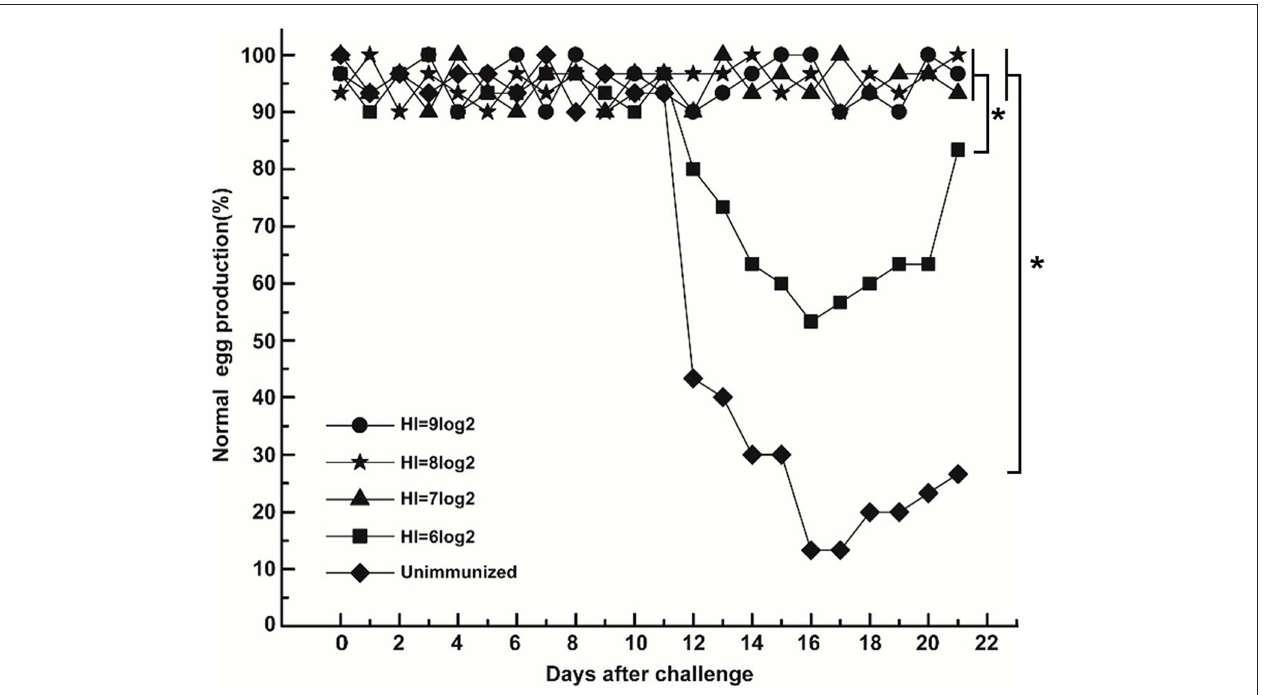
FIGURE 3 | Correlation between HI titer and efficacy of the fiber protein. Based on HI titer, the immunized laying hens were regrouped to HI titer of 9, 8, 7, and 6 log2 and orally challenged with DAdV-1. Egg production rate was calculated daily. Asterisk denotes a statistically significant difference ( p < 0.05).